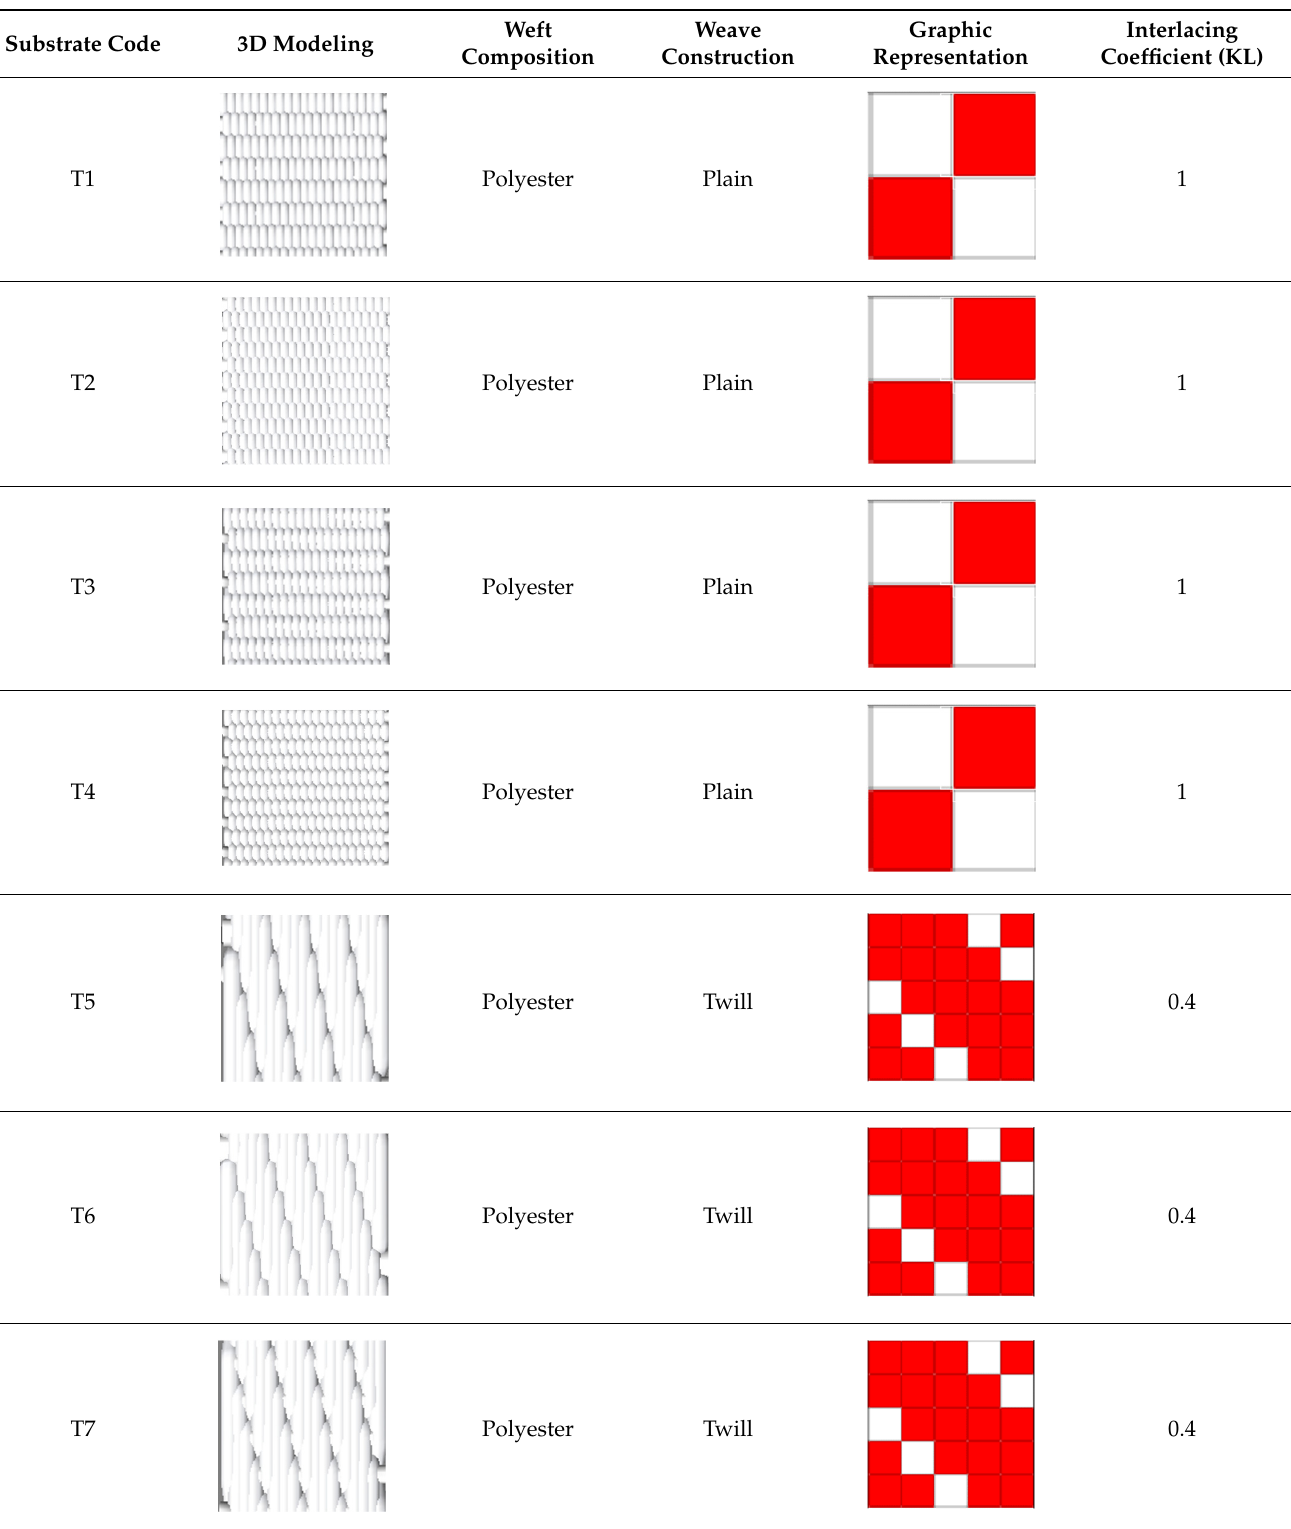
Table 1. Textile substrate’s characterization (I): composition and